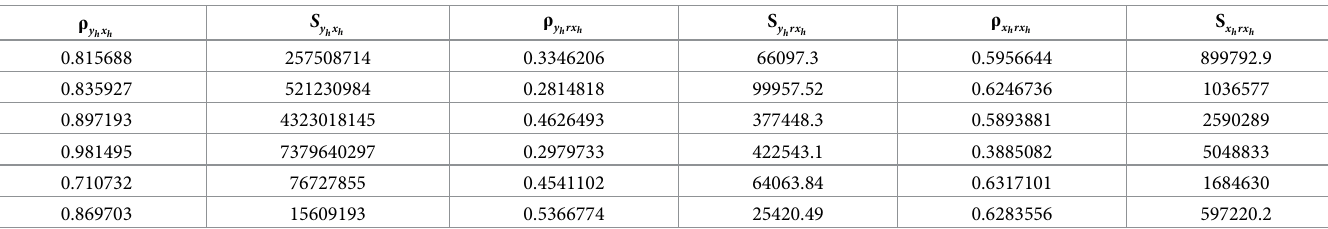
Table 2. Correlation and covariance’s using Population